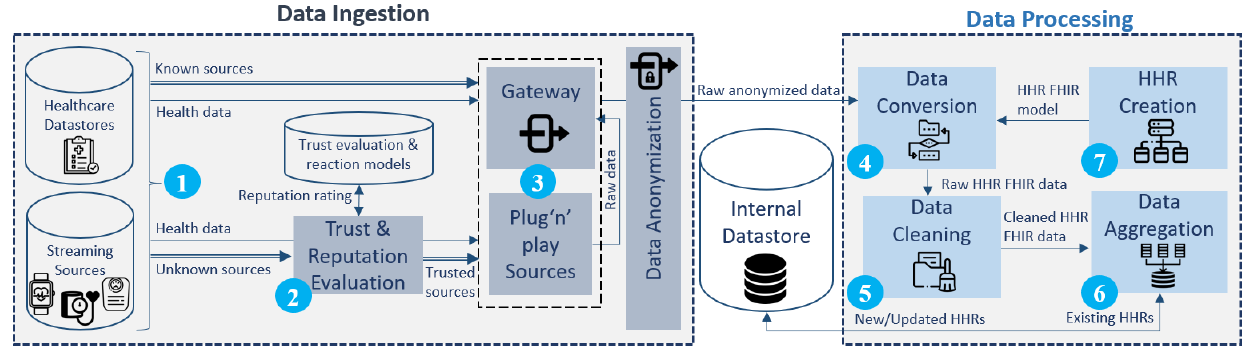
Figure 1. Overall architecture of the proposed